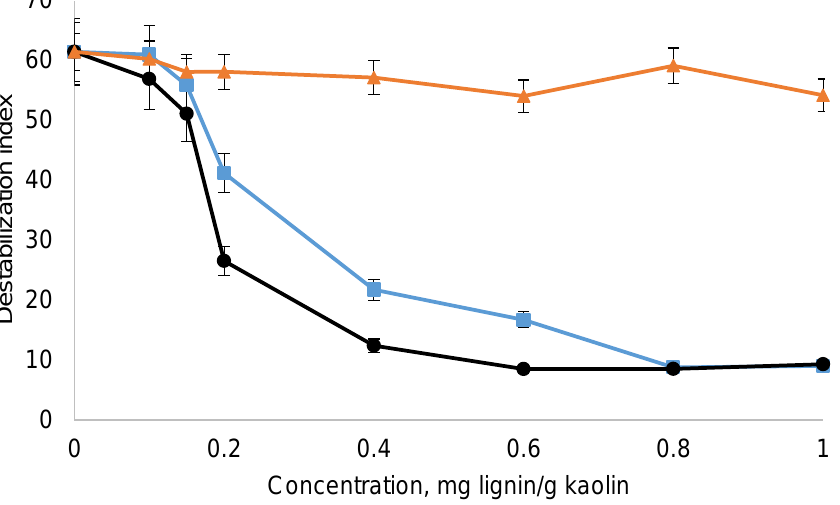
ff ect of lignin dosage on destabilization